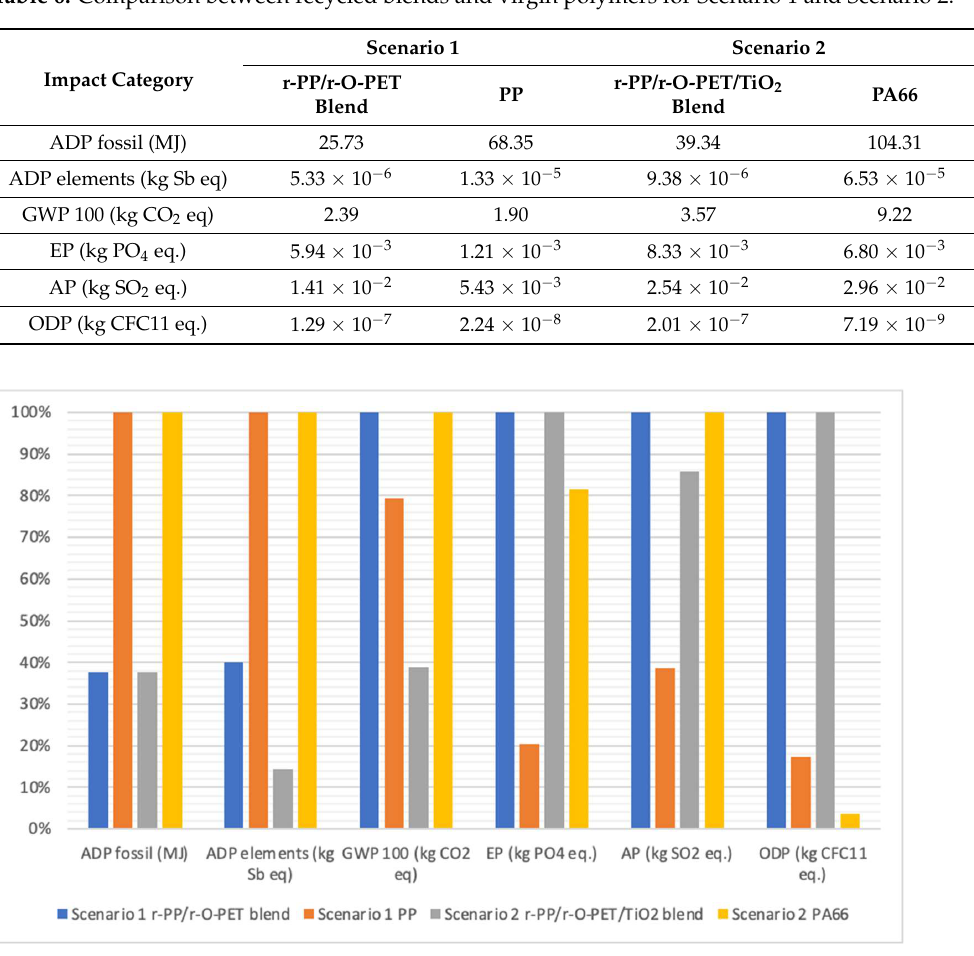
Figure 3. Relative indicator results of the impact categories for both scenarios. For each indicator, the maximum result is set to 100%. maximum result is set to